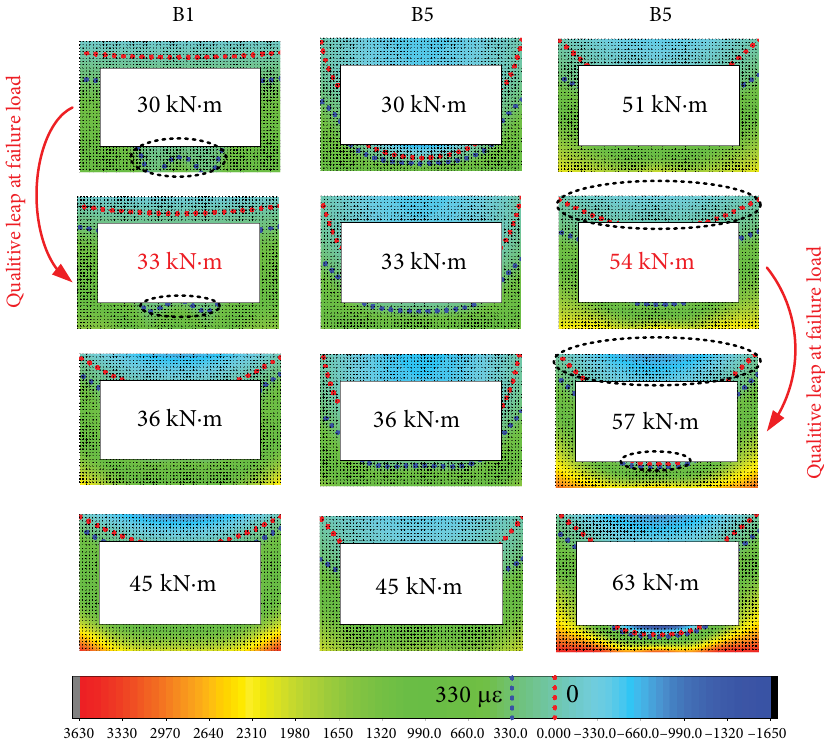
Figure 12. The strain contour maps of B1 and